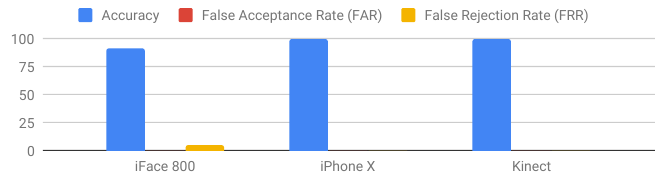
Figure 3. Overall results from the test-cases for the investigated 3D-camera